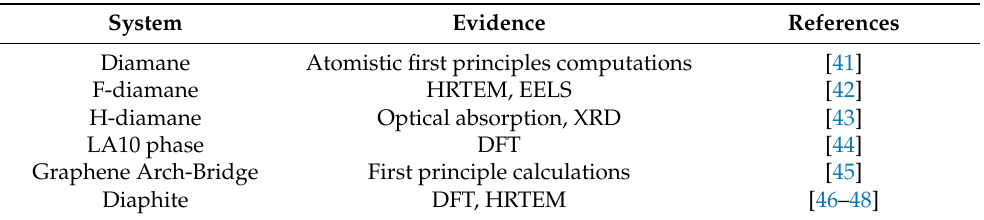
Table 1. Exoticnanocarbonphasesandarchitecturesduetographene-diamondreconstructionatthenanoscale.